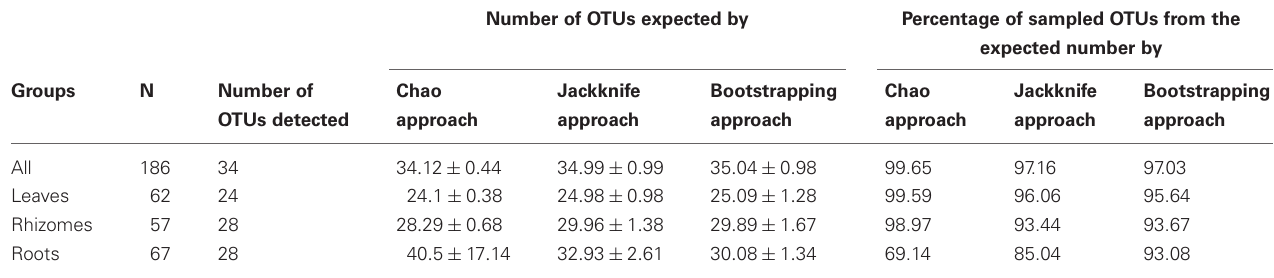
Table 1 | Number of total OTUs detected in each tissue for all the samples tested; total number of OTUs estimated by different approaches: Chao, Jackknife and Bootstrapping; and percentage of the total estimated OTUs detected in the samples.